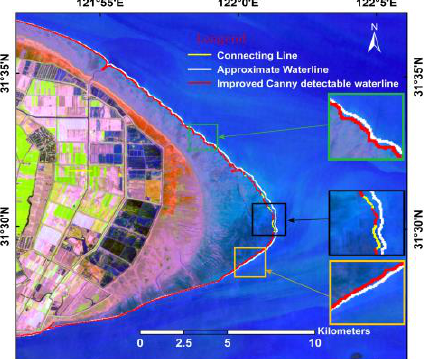
Figure 9. High spatial resolution waterlines extracted from remote sensing images from 20 April 2007.